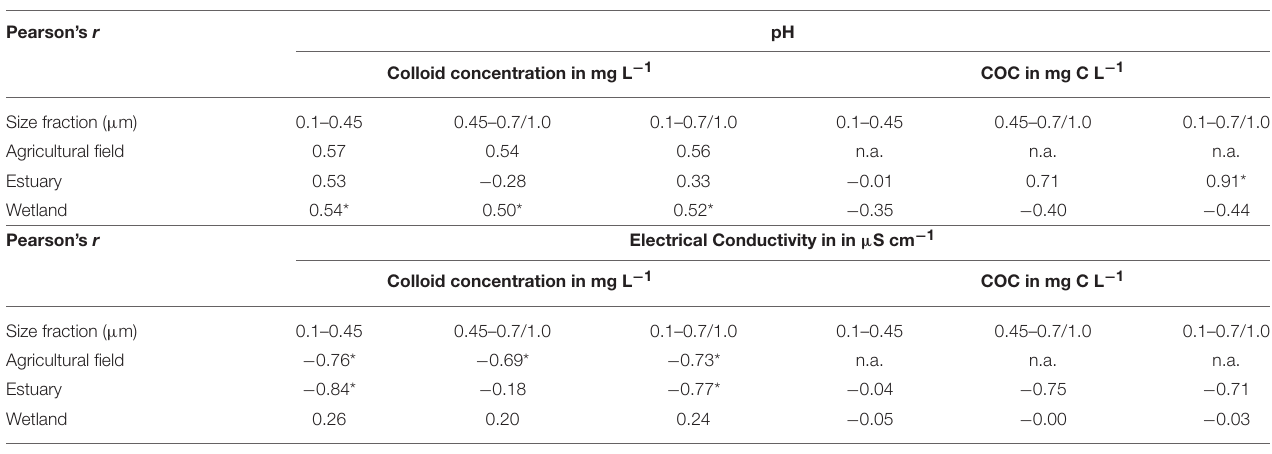
TABLE 3 | Pearson’s correlation coefficient between pH, EC and colloid and OC concentration among different size